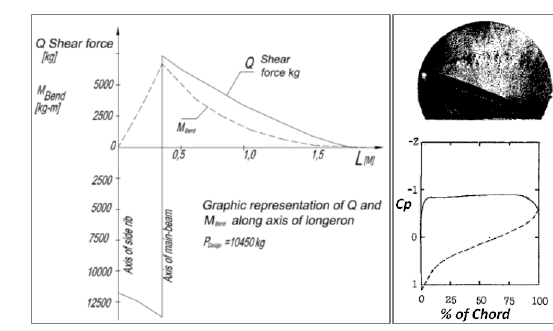
Figure 3: (a) Loading Diagram (b) NACA0006-63 Cp